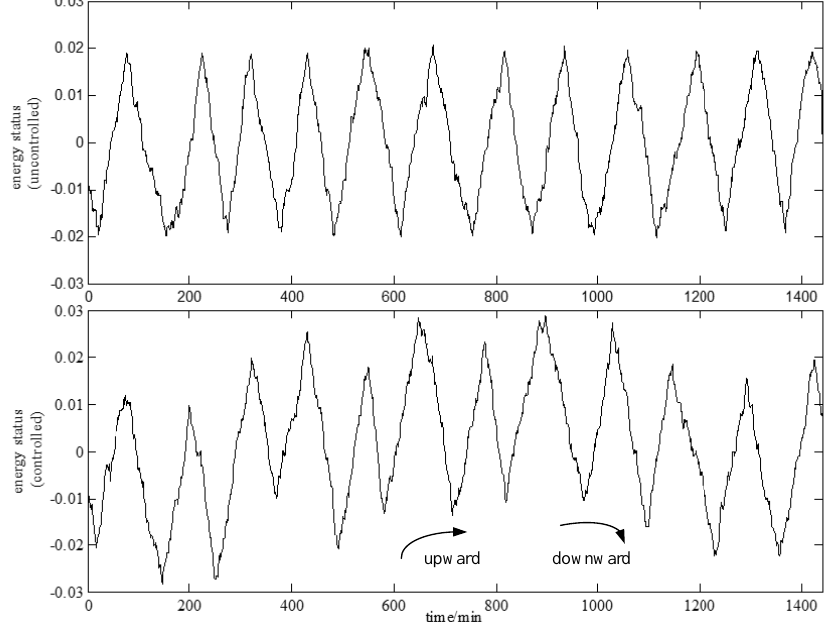
Figure 11. Energy state of a single DE in the uncontrolled ( top panel ) and controlled ( bottom panel ) case.